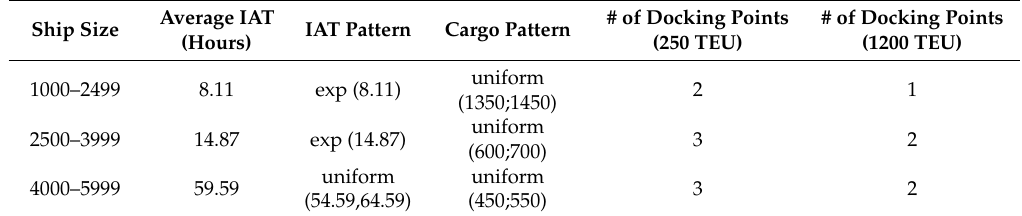
Table 3. Input data for detailed simulations.